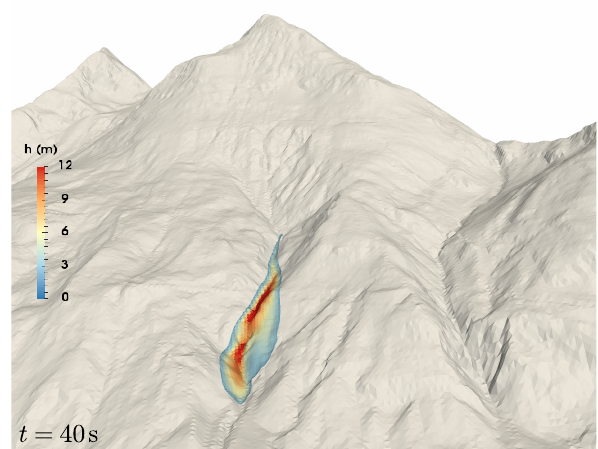
Figure 5. Perspective view on the OpenFOAM simulation with mean cell size (cid:49) = 7 . 45m and first-order interpolations in Par- aView. The colour scale represents flow thickness, which is clipped at 0 . 5m. Terrain data: